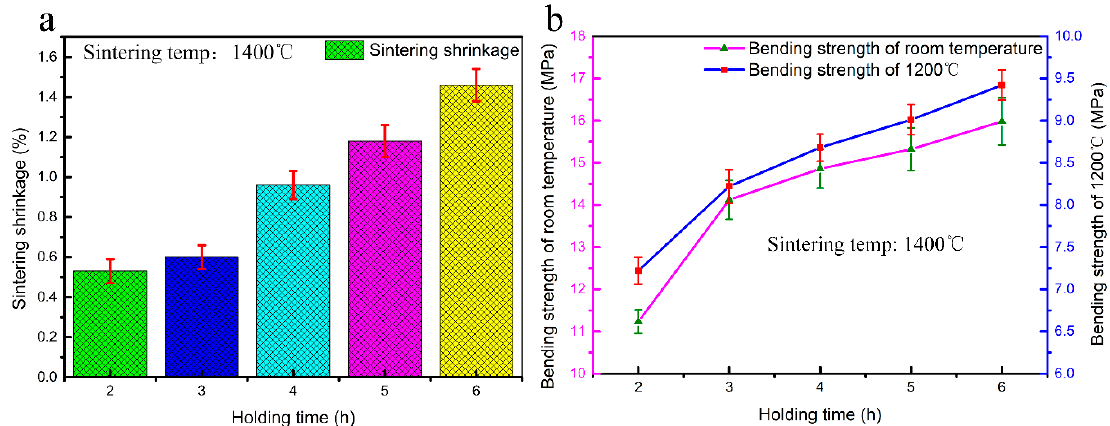
Figure 9. The effect of the holding time on the performance of the mould: ( a ) sintering shrinkage; ( b ) bending strengths at room temperature and 1200 °C.